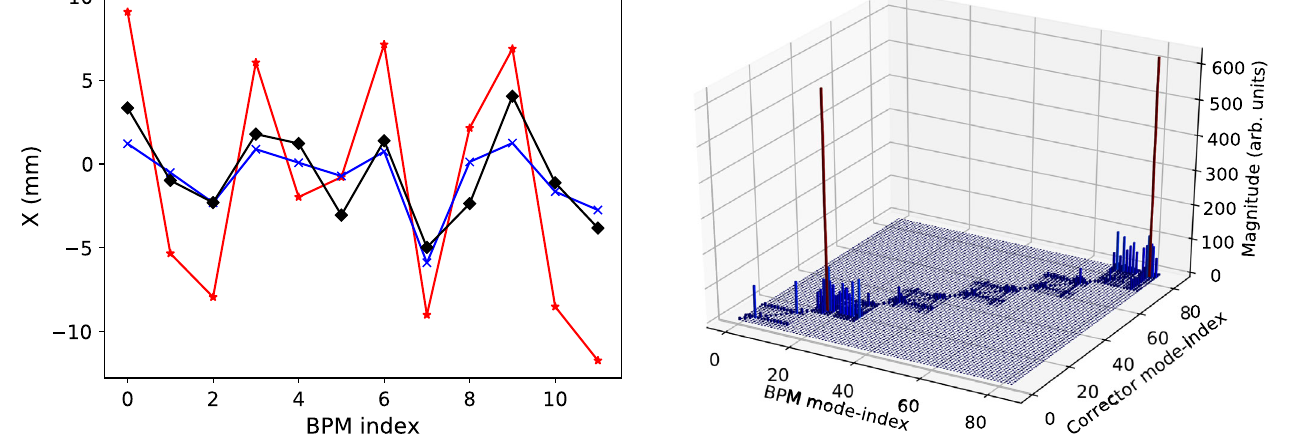
FIG. 5. Magnitudes of the complex entries of the block diagonal matrix D defined in Eq. (25), calculated for the case of ignoring the beta beating in the x plane of SIS100.